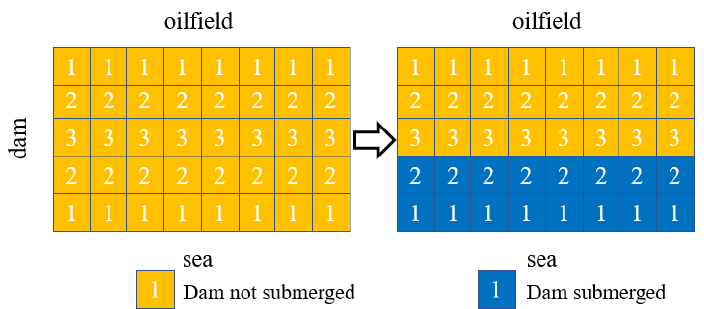
Figure 19. The yellow grid represents the dam that has not been submerged, and the blue grid represents the dam that has been submerged due to sea-level rise. The numbers in the boxes represent elevation value.